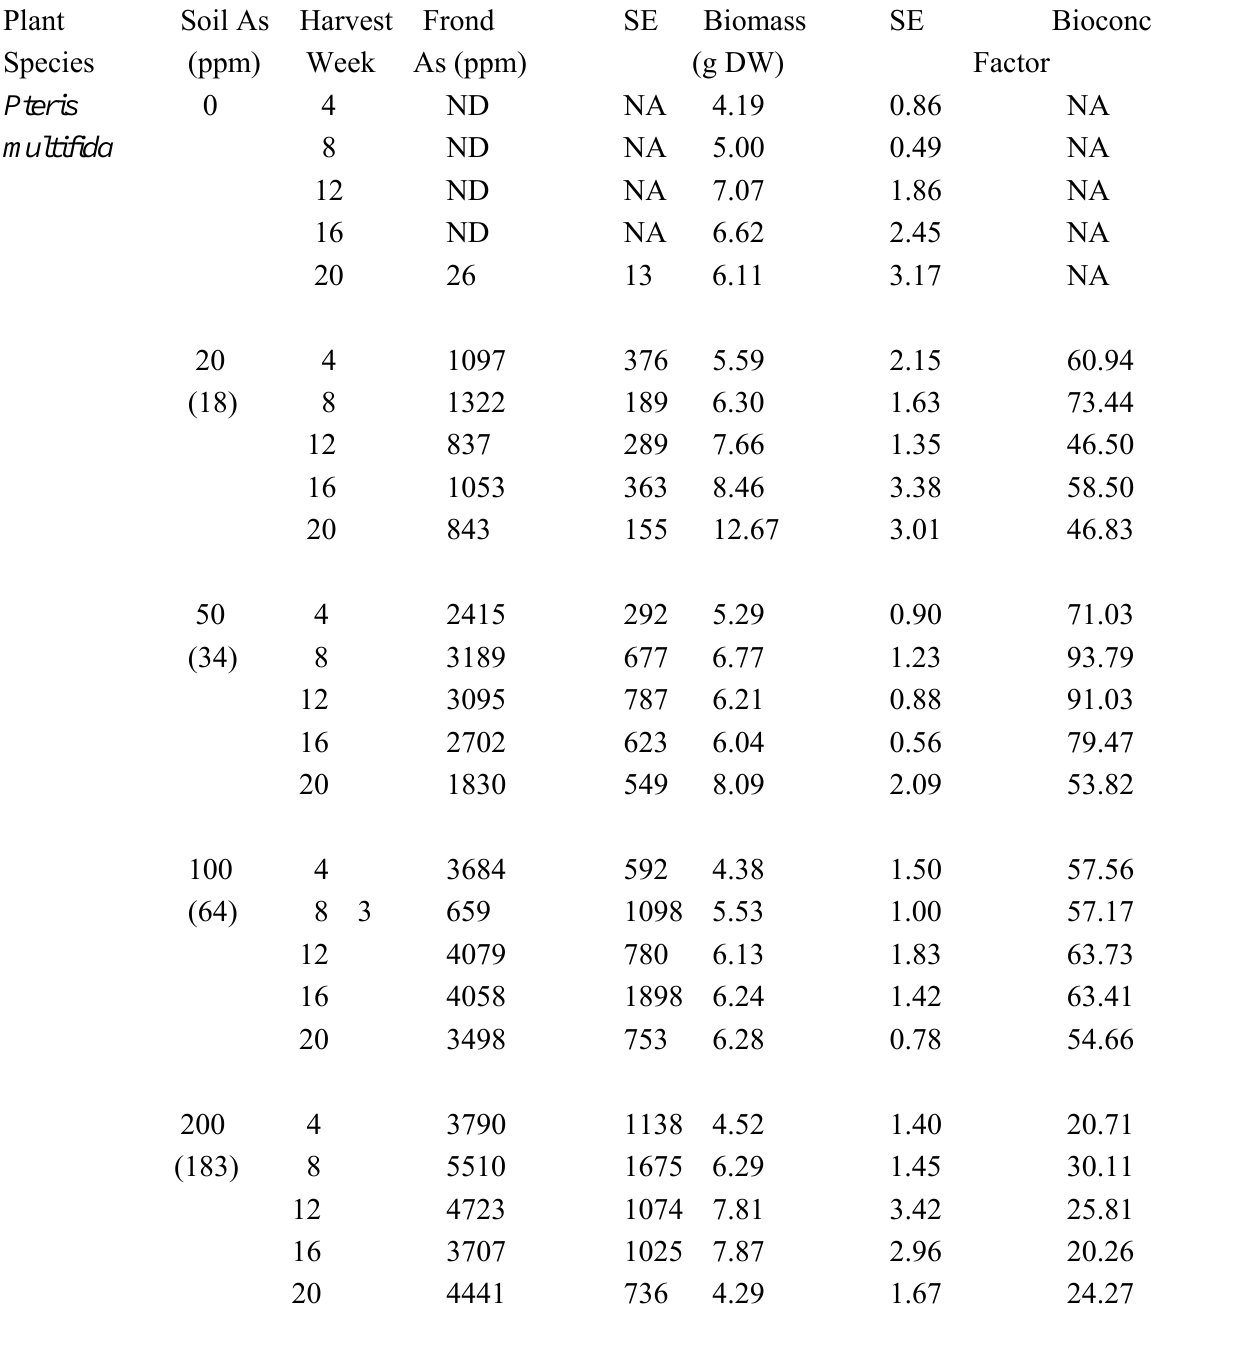
Table 3. Summary Results for arsenic uptake in Pteris multifida. SE is the standard error. Soil As lists predicted concentration and actual concentration in